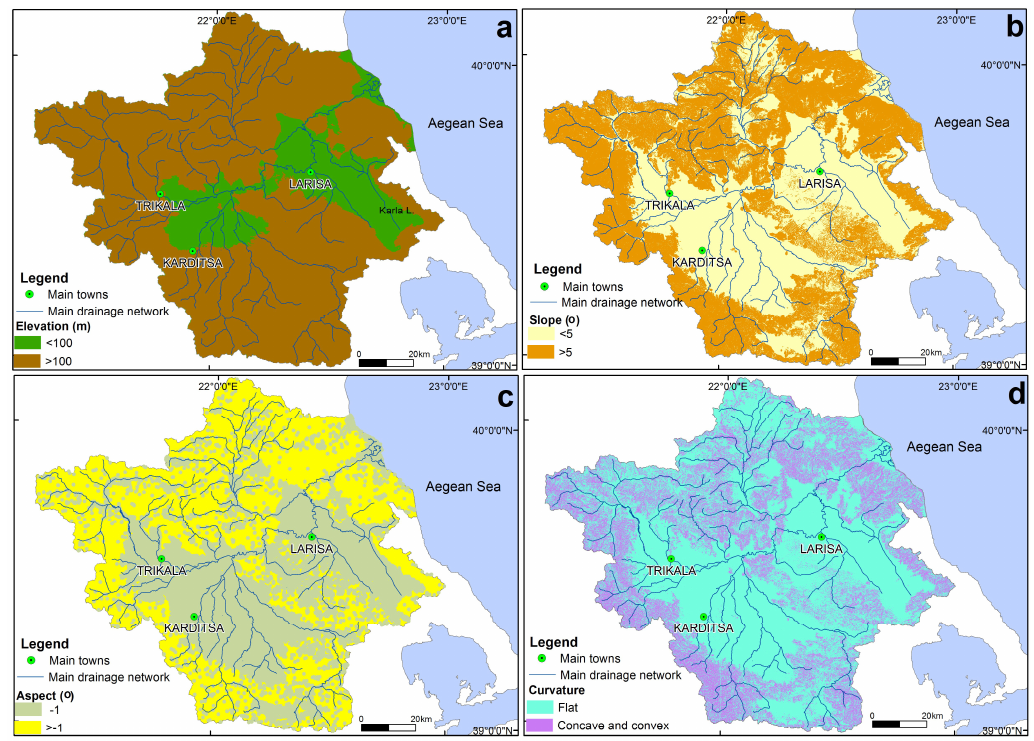
Figure 3. Thematic maps of the four geomorphological parameters: ( a ) elevation; ( b ) slope; ( c ) aspect; ( d )